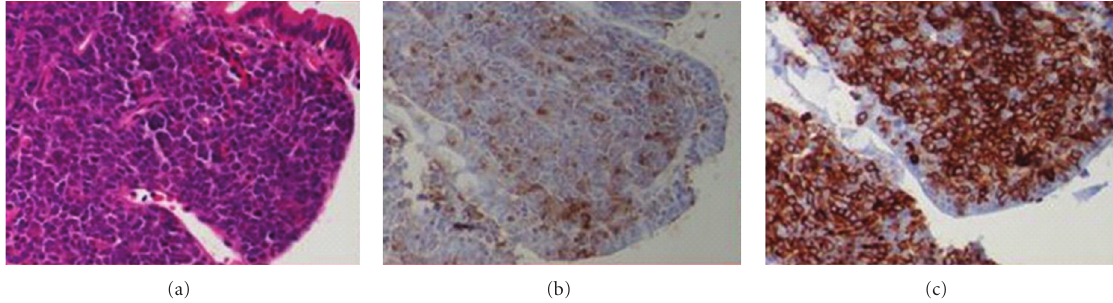
Figure 3: (a) Duodenal biopsy showing infiltration of blastoid cells into the mucosa. (H&E original magnification, × 400). (b) Myelo- peroxidase (MPO) staining reveals same population of cells staining positive for MPO (original magnification, × 400). (c) Tumor cells staining bright yellow (positive) for CD34 (original magnification, × 400). (Image courtesy of Dr Mu Su).